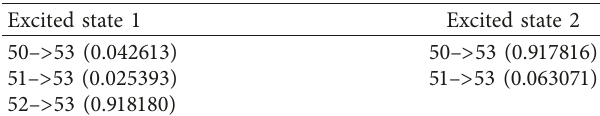
Figure 9: Simulated fluorescence spectra in acetonitrile due to simultaneous two bonds twist angles variation: (a) and (b) represent fluorescence due to relaxed scan steps 1–25 for D-S1 (the insets show the dihedral angles of scan grid points); (c) represents the case of D-S2 scans. Computed using TD-DFT (cam-B3LYP/6-31G ∗ model). All spectra are plotted by GaussView 6. Table 1: The most probable contributions of TD-DFTexcited states